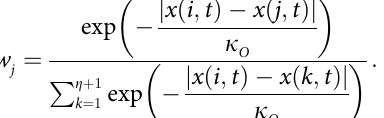
Fig 2. The effect of the parameter κ function of the difference in opinion (| x ( i , t ) − x ( j , t )|) as at a given time t . All weights are scaled so that